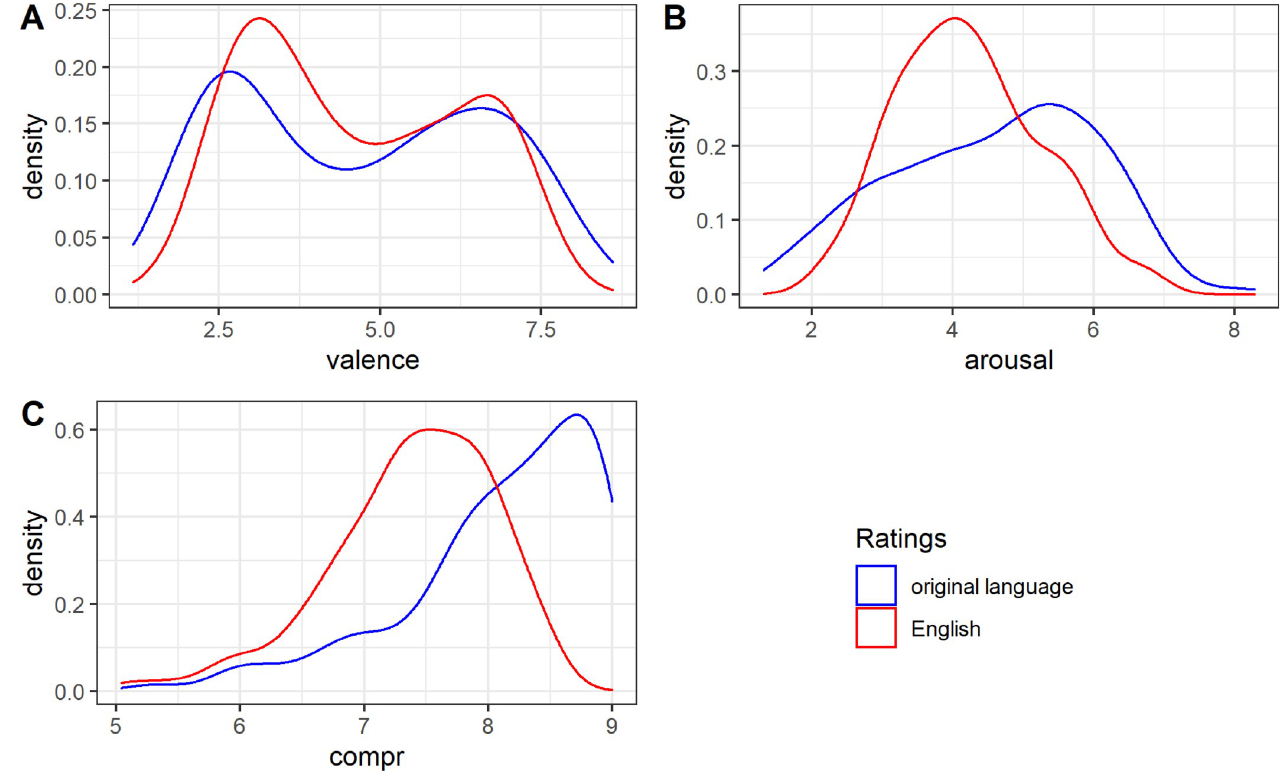
Fig 1. Distributions of the valence, arousal and comprehensibility ratings for original texts and English translations. (A) Valence ratings. (B) Arousal ratings. (C) Comprehensibility